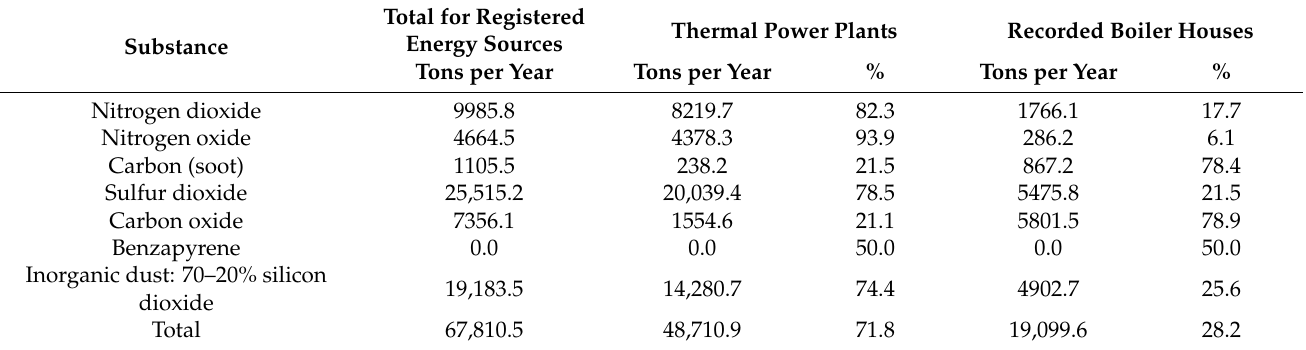
Table 5. Total air pollutant emissions from energy sources in Krasnoyarsk. Source: Heat Supply Schemes of